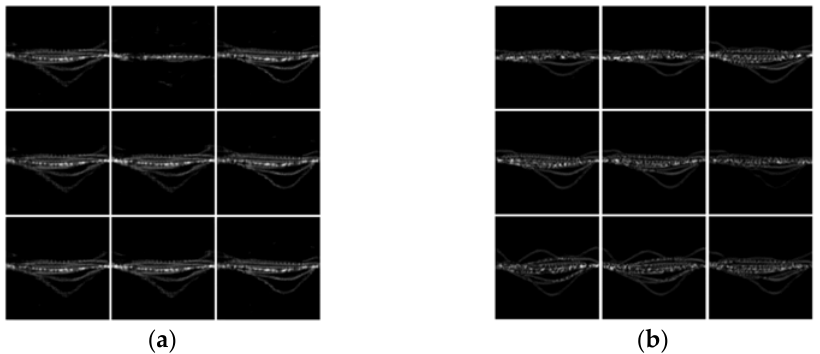
Figure 9. Generated samples of the pedestrian database obtained using the modified Boulic model.